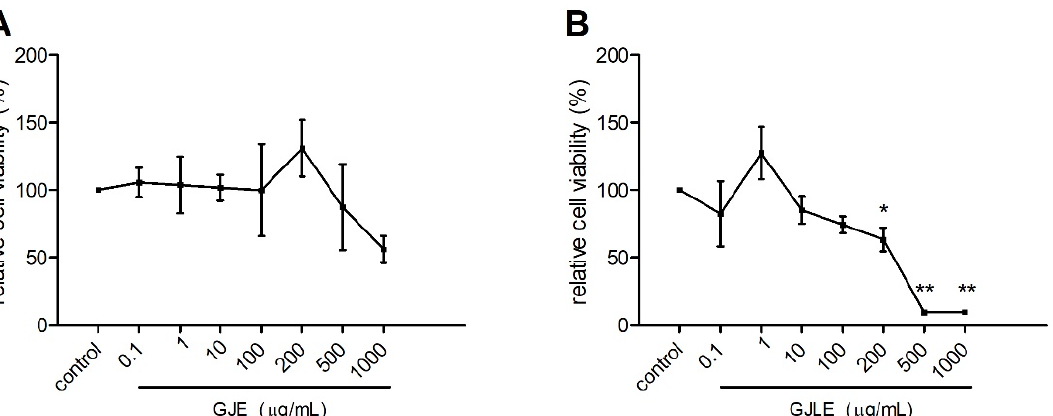
Figure 3. Effects of G. jasminoides ( A ) and G. jasminoides f. longicarpa ( B ) flower essential oils on the viability of MH-S cells. Values represent the mean ± SD from three independent experiments, * p < 0.05 and ** p < 0.01 vs. the control treatment; one-way ANOVA was used, and Duncan test was used for post hoc analysis.